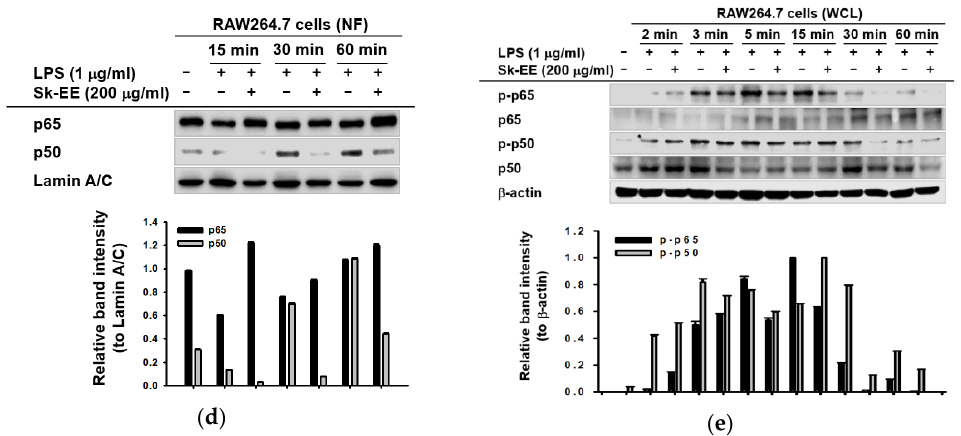
Figure 2. Effects of Sk-EE on the mRNA expression of inflammatory genes and nuclear translocation of inflammatory transcription factors. ( a ) RAW264.7 cells were pretreated with indicated concentrations of Sk-EE and induced by lipopolysaccharide (LPS) (1 µ g / mL) for six hours. mRNA expression levels of iNOS, COX-2, IL-1 β , and GAPDH (as a control) were measured using reverse-transcription polymerase chain reaction (RT-PCR) and agarose gel electrophoresis. ( b , c ) HEK293T cells were transfected with NF- κ B-luc, MyD88 or TRIF, and β -gal (as a control) genes by PEI transfection for 24 h, then treated with indicated doses of Sk-EE for 24 h. The expression of NF- κ B was determined by luciferase assay. ( d , e ) RAW264.7 cells were pretreated with Sk-EE (200 µ g / mL) for the indicated times and nuclear fractions or whole-cell lysates for detecting p65, p50, p-p50, p-p65, and Lamin A / C were analyzed by Western blotting. # p < 0.05 and ## p < 0.01 compared to normal group; * p < 0.05 and ** p < 0.01 compared to control group. Data presented ( b , c ) are expressed as mean ± SD of experiments performed with 6 samples. NF: nuclear faction. + : treatment, − : no treatment.